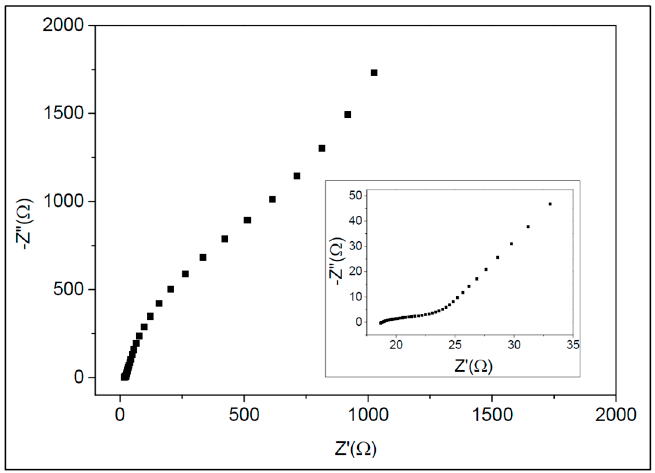
Figure 8. Nyquist plot of the micro-SC. The impedances were measured at a bias of 0.1 V, at frequencies from 20 Hz to 10 kHz.